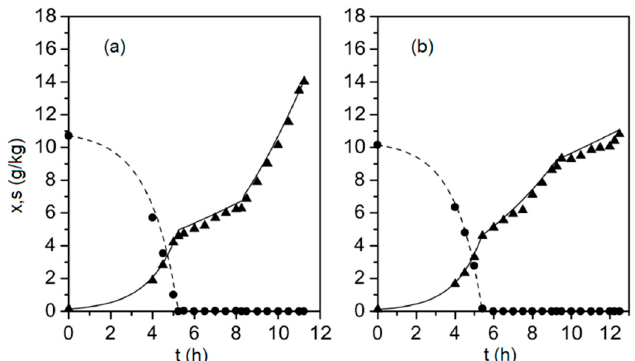
Figure 1. Biomass (solid triangles) and glucose (solid circles) concentrations measured during two fed-batch cultivations (subplots ( a ) and ( b ), respectively), along with the corresponding model outputs (solid line and dashed line), determined from Equations (1)–(9).